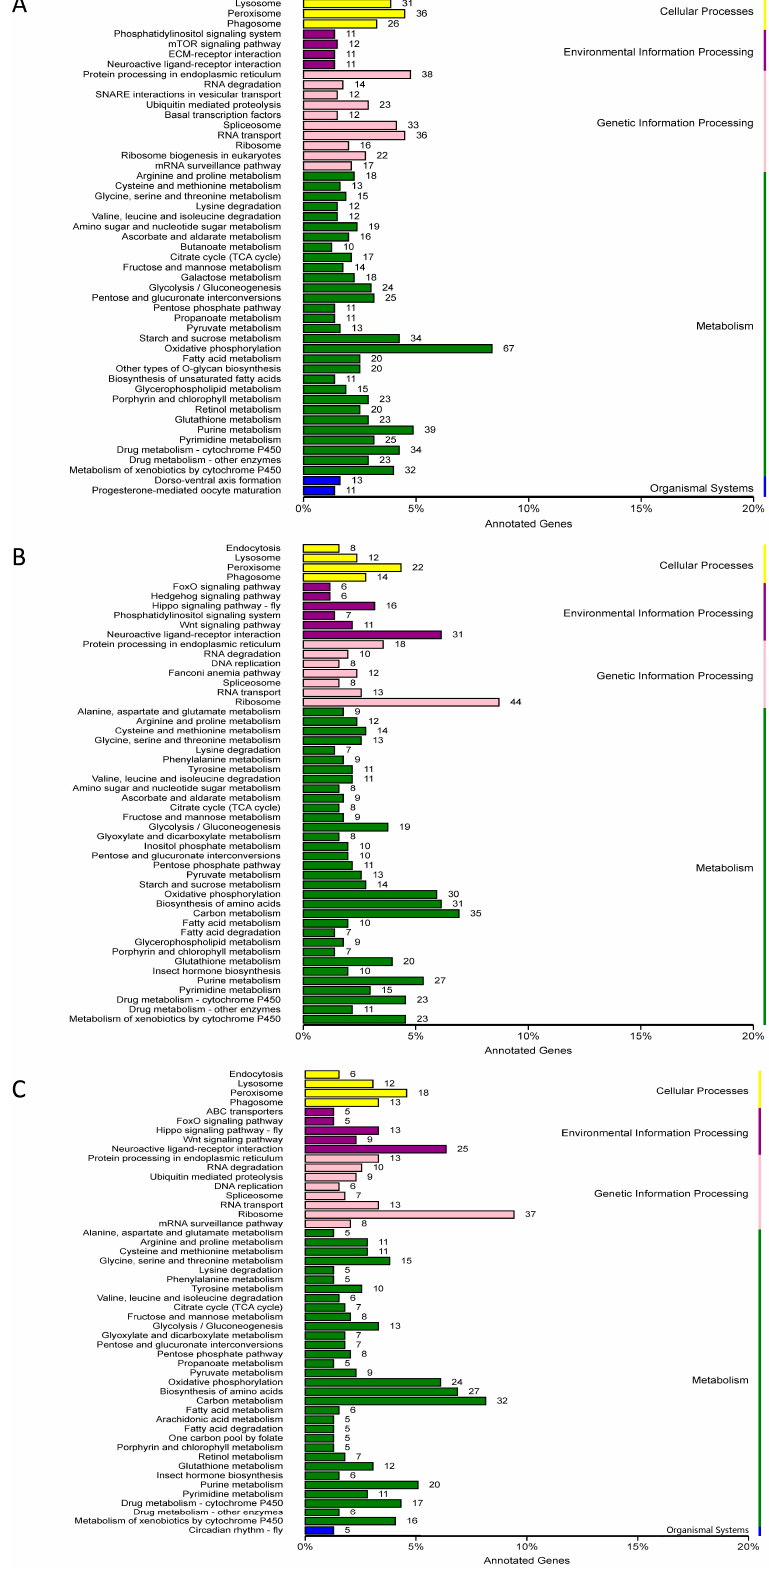
Figure 4. DEGs classified according to the pathway type in KEGG. The abscissa shows the ratio of the number of genes that are annotated to certain pathway and the number of genes that are annotated in total. The ordinate shows the name of the KEGG metabolic pathway. The KEGG classification of DEGs for larvae, females and males were shown by ( A ), ( B ), and ( C ), respectively.